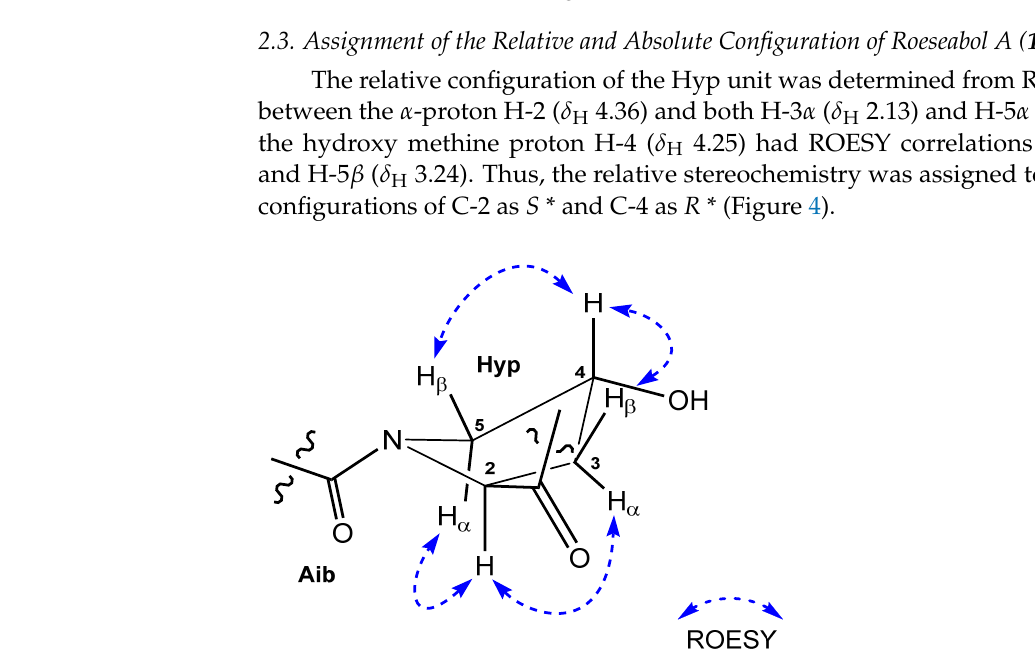
Figure 3. ESI MS/MS fragmentation of roseabol A ( 1 ).